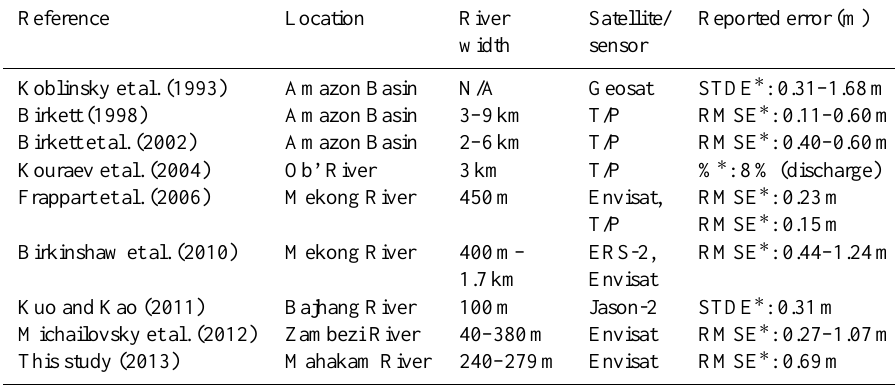
Table 3. Summary of studies on satellite radar altimetry for water level over river.